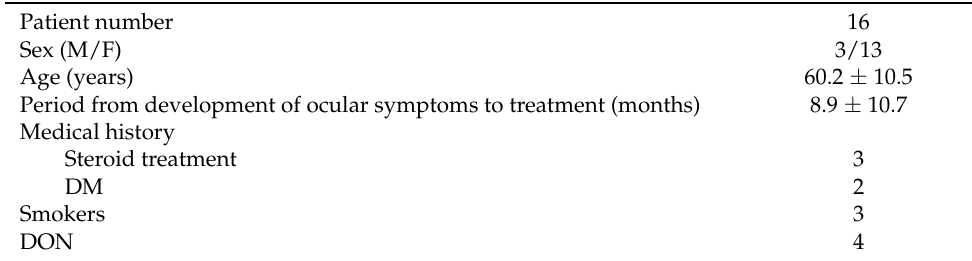
Table 2. The demographic data.